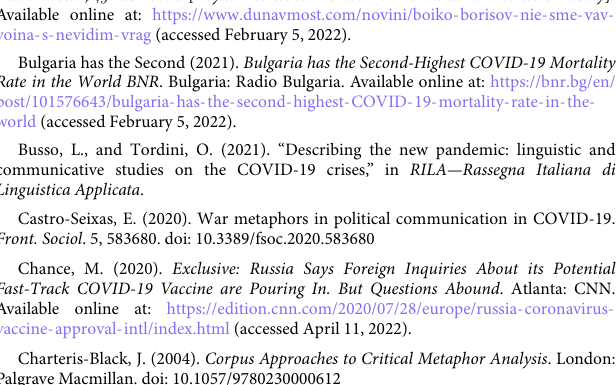
voina-s-nevidim-vrag (accessed February 5,